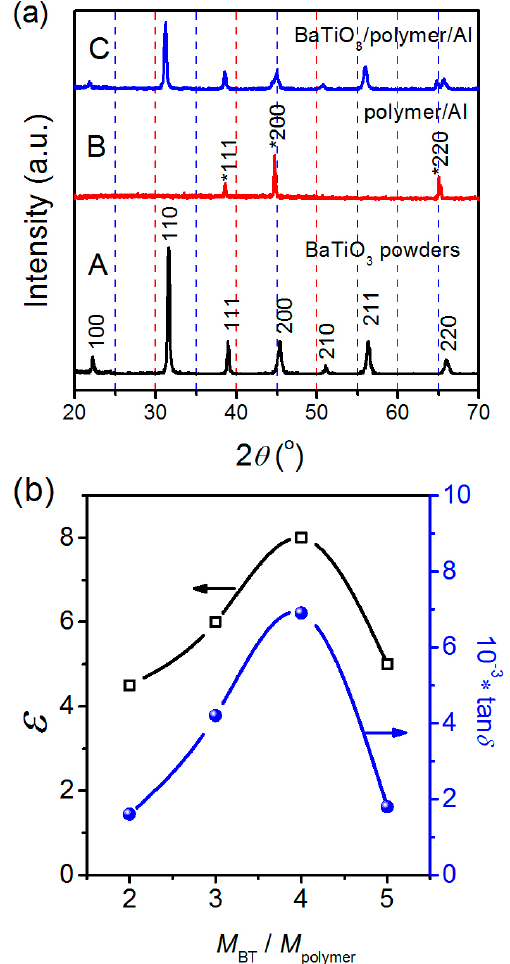
Figure 4. ( a ) Typical XRD patterns of the pristine BT powders, polymer/Al foil and BPA